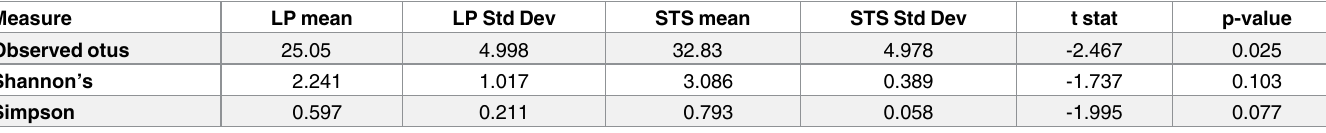
Table 1. Alpha diversity measuresbased on a rarefactiondepth of